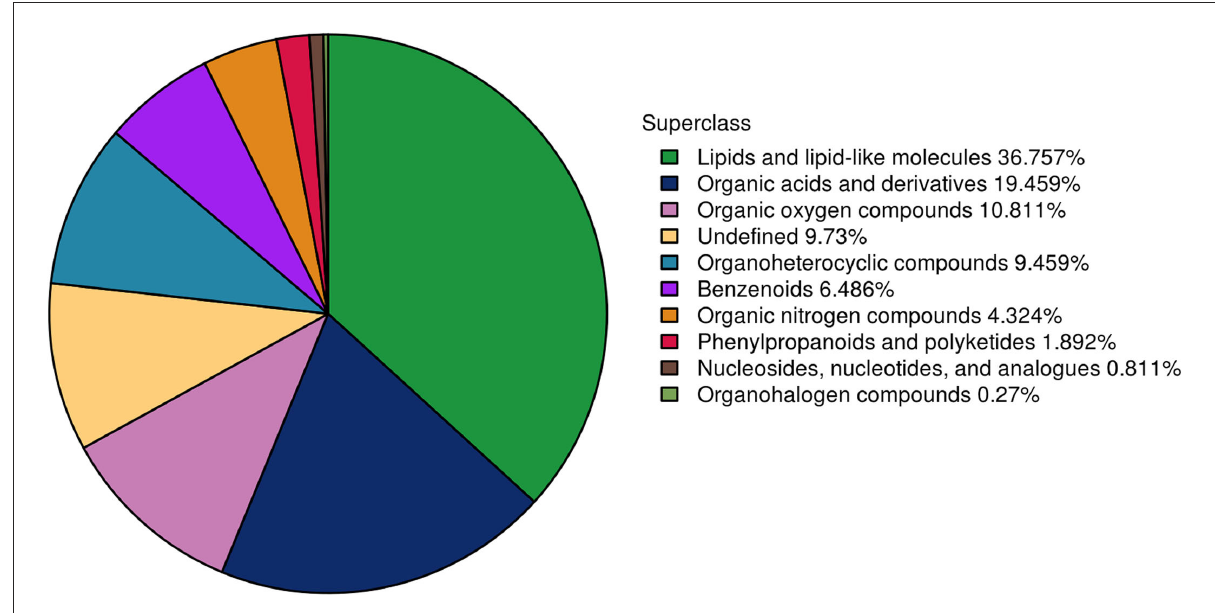
FIGURE2 Presentation of the metabolomic